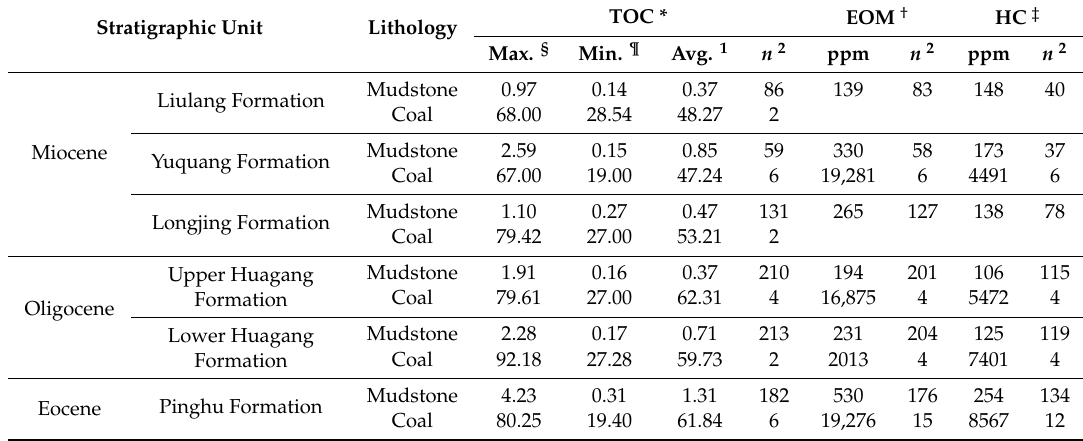
Table 2. Abundance of organic matter in the Xihu Sub-basin (from Ye et al. [2]). Stratigraphic Unit